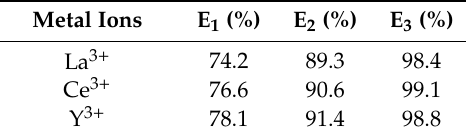
Table 4. Results of desorption e ffi ciency.